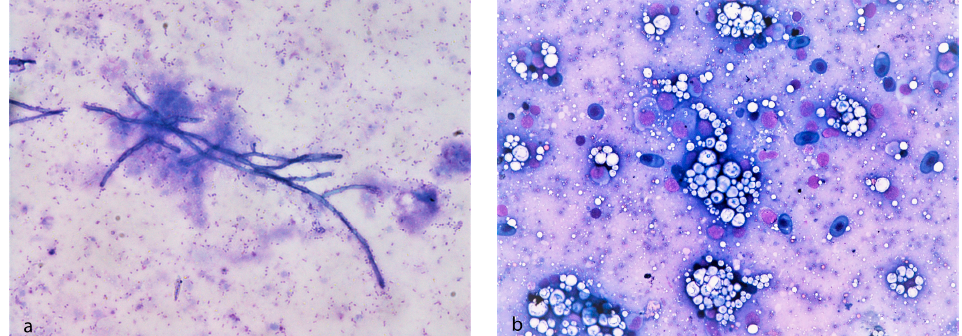
Figure 3. Cytological examination of Huso huso through May–Grünwald–Giemsa staining. ( a ) Cytologic smears from coelomic serohemorrhagic exudate showing several rod-shaped blue bacteria in the background and dark-blue branched septate hyphae. ( b ) Cytologic smears from kidney showing acellular, crystalline, material consistent with mineral deposit (nephrocalcinosis).